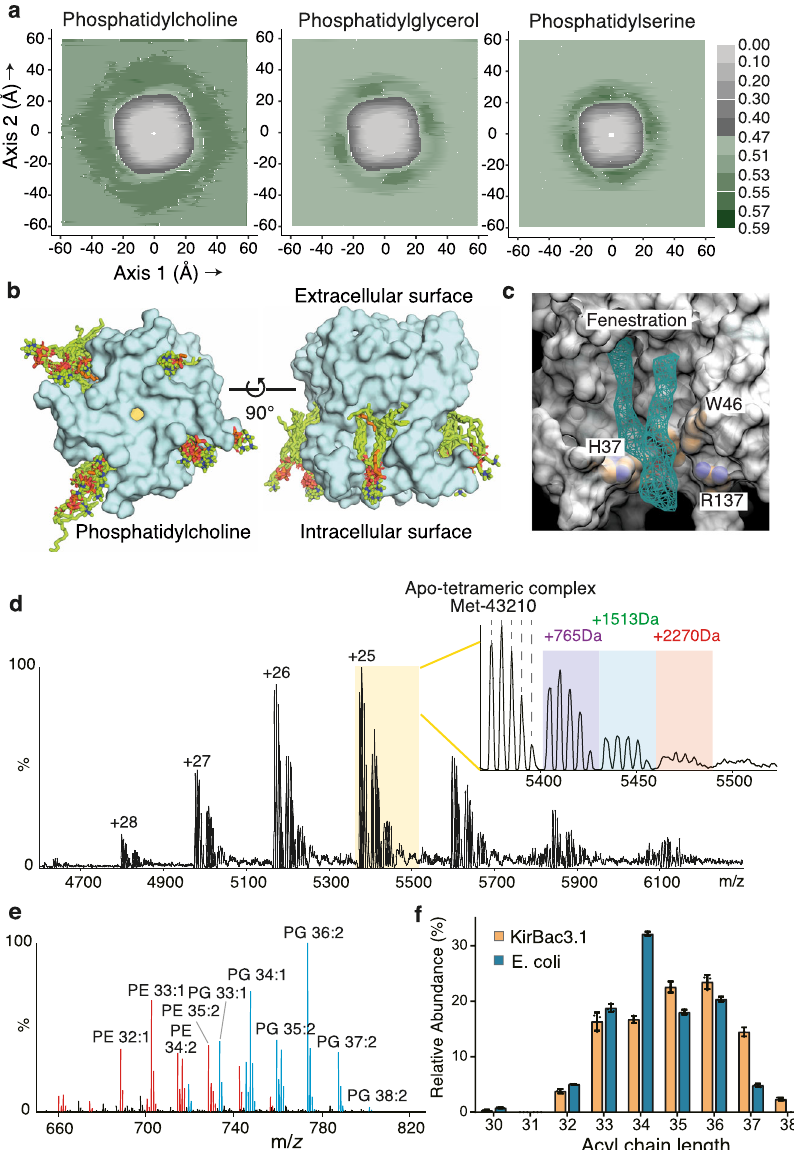
Fig. 4 Anionic phospholipids bind tightly and speci fi cally to the pore. a Projections along z of coarse grained simulation data showing the number density distribution of lipid head groups surrounding the pore. Source data are provided as a Source data fi le. b The position of protein associated POPC lipids from 10 randomly selected conducting structures from steered MD superimposed on the crystal structure of the KirBac3.1 pore illustrate a binding cleft in the molecular surface connecting cytosol and fenestrations. POPC lipids are depicted as green sticks, whereas the lipidic fragments depicted in orange arise from the crystal structure. c An isosurface of the fenestration-bound lipids from these calculations demonstrates the relationship of lipid to a canonical lipid-binding site; the isosurface was calculated from 292 lipid molecules at a mass density contour level of 0.15. The isosurface is shown as teal mesh, and sphere representations of the His, Arg and Trp are coloured on an otherwise grey molecular surface. d Native mass spectrum of KirBac3.1 protein in 200 mM ammonium acetate (pH = 8.0) and 0.5% C8E4 (2× the critical micelle concentration) reveals tetrameric complexes with up to four N-terminal methionine truncations (Met- 0, 1, 2, 3 and 4), and with one to three phospholipids binding ( + 765 Da, + 1,513 Da and 2270 Da, respectively). e Lipidomics analysis of KirBac3.1 suggests that PG is enriched amongst the co-puri fi ed lipids. f Comparison of the total acyl chain length of PG in KirBac3.1-co-puri fi ed lipids and total E. coli lipids suggests that KirBac3.1 preferentially associates with long chain lipids. Error bars represent mean ± SD, with n = 3; individual measurements are overlaid as dot plots. Source data are provided as a Source data fi condensation of PS and PG headgroups revealed in coarse- lipid binding site using the all-atom MD data. This revealed that grained simulations suggest additional electrostatic contacts even with neutral PC, 95.5 % of the lipids occupying fenestrations facilitated by anionic lipids in pore and intracellular assembly had head groups falling within 5 Å of the Arg137, Trp46 and are critical in attracting and con fi ning PS and PG. The nexus of His37 pocket, indicating that lipids occupying fenestrations electrostatic contacts to both pore and intracellular elements of almost invariably have tightly bound head groups. An isosurface the protein in the vicinity of the tetramer interfaces is a of the fenestration-bound lipids from frames in which the K + ion is found transiting the Leu124 collar demonstrates the relation- prerequisite for coupling interdomain motions of the Kir ship of lipid to a canonical lipid-binding site (Fig. 4c). The channel 13 to the movement of the lipid tails engaging Leu124.